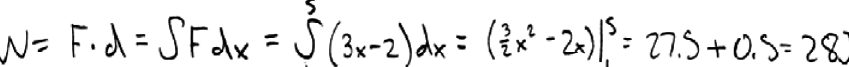
FIG. 12. Use of quantitative approach to solve for a quantitative solution from force-position equation.